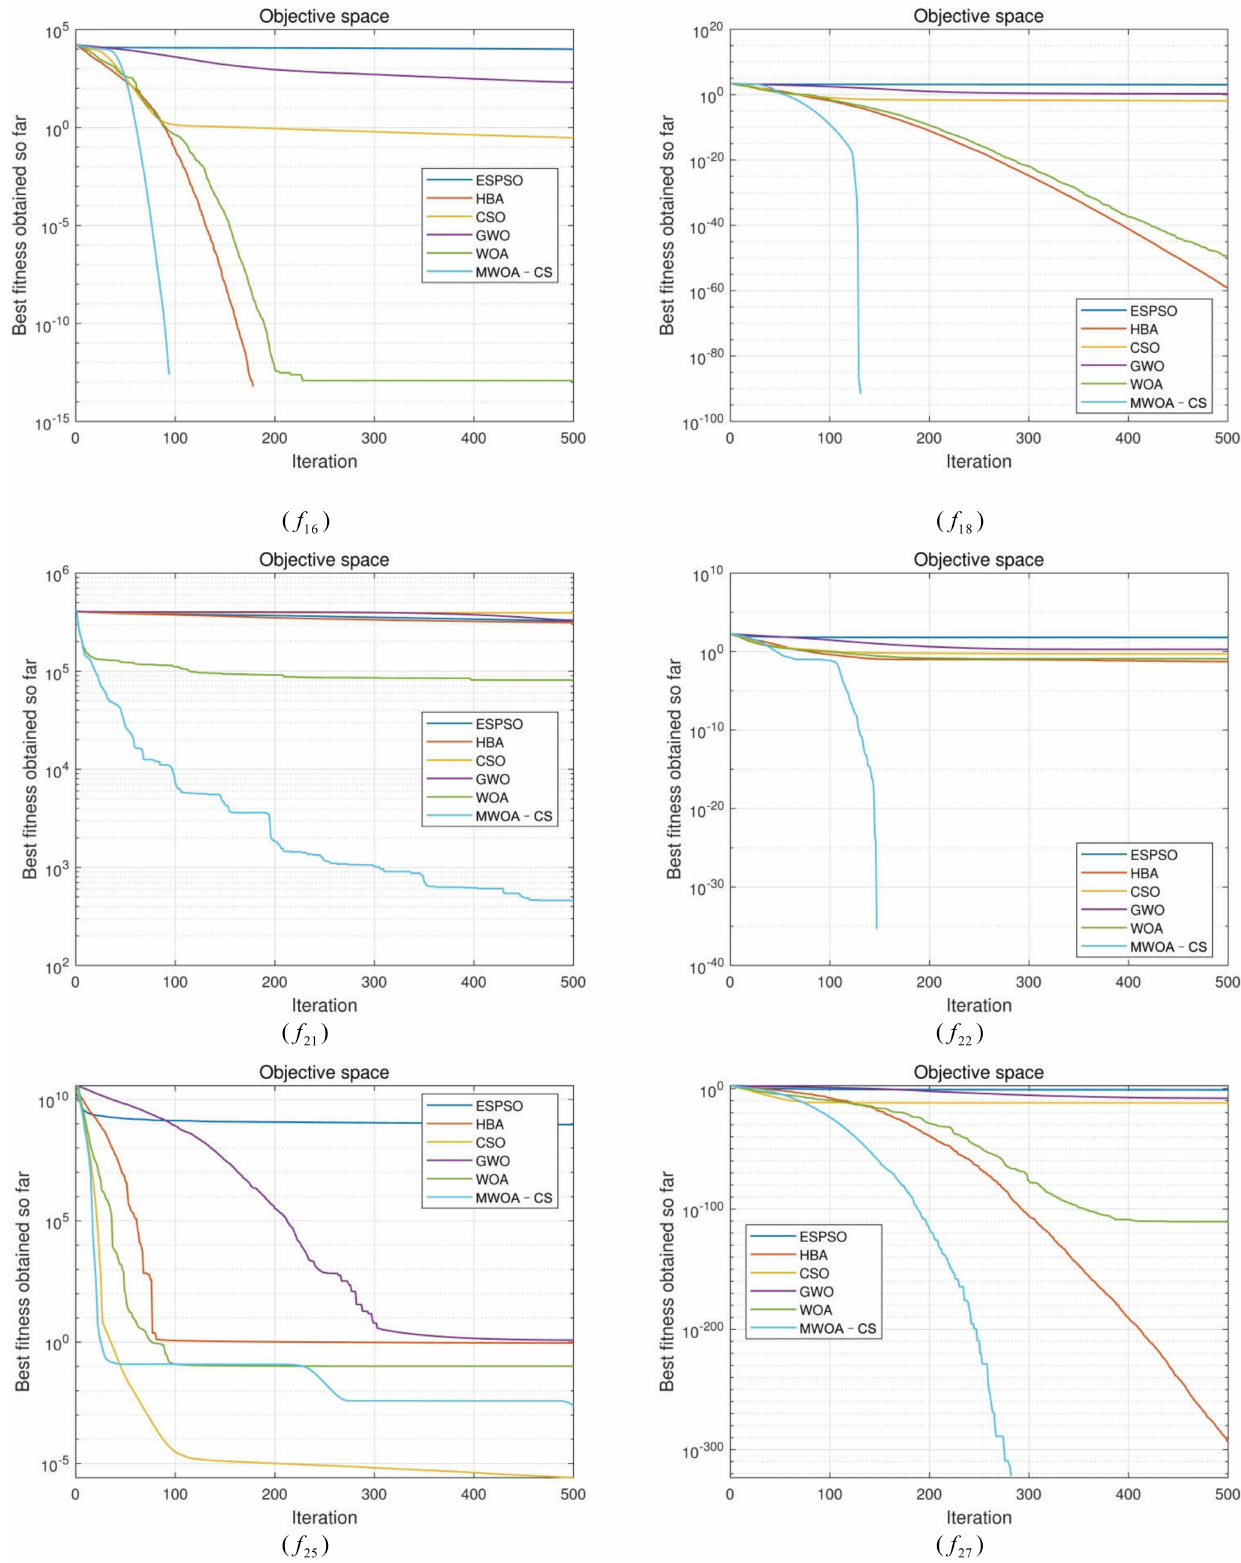
Figure 4. Convergence curves for some selected unimodal /multimodal problems with dim =